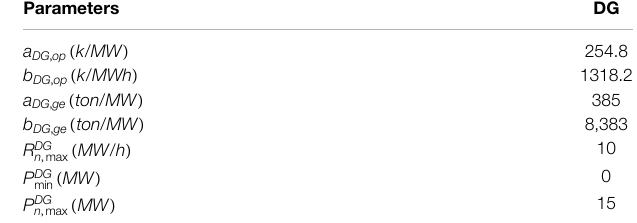
TABLE 1 | Parameters of diesel generators and power limits